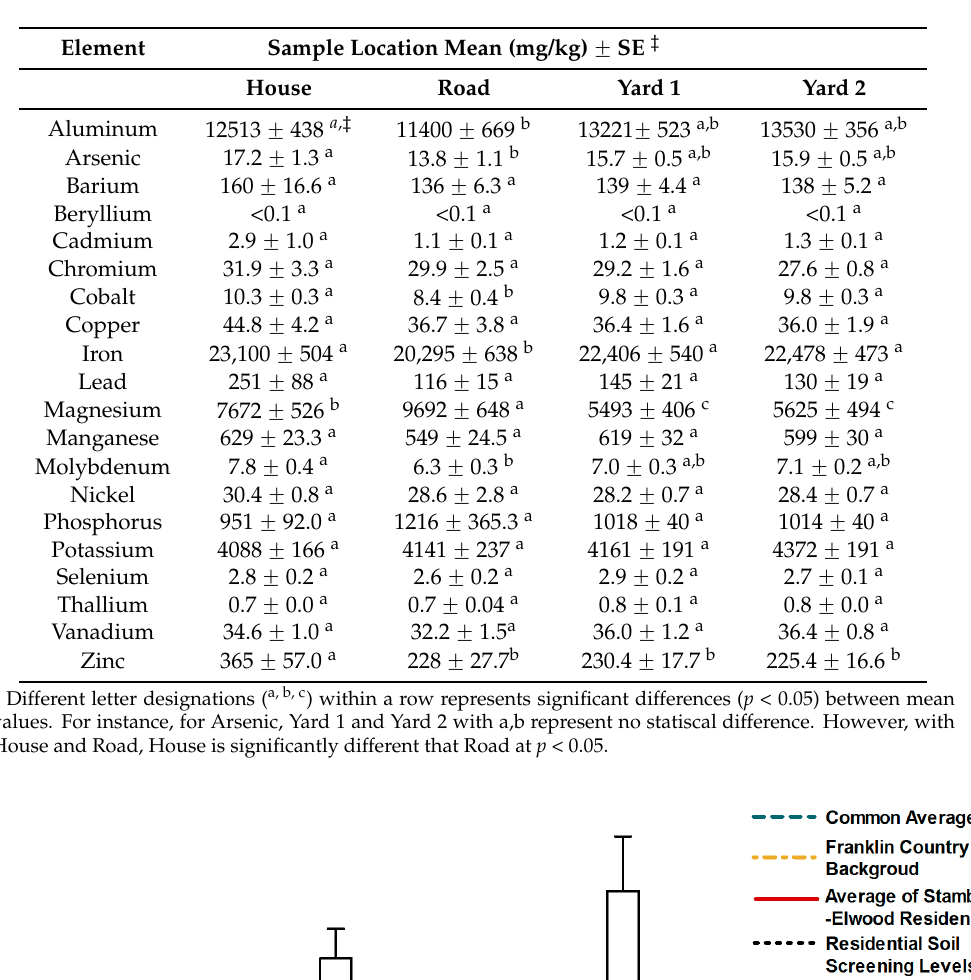
Figure 8. Residential urban soil level of Cu in the Stambaugh-Elwood community versus Franklin County (background), common averages and residential screening levels (RSLs) (mg/kg soil). Soil samples were taken from 21 of 46 residences that consented for the study in compliance with OSU IRB Protocol 2014B0445-exempt. Each sample consisted of four subsamples. Analysis proceeded following EPA Method 3051A, and digests were subsequently analyzed for metals using an Agilent 700 ICP-OES